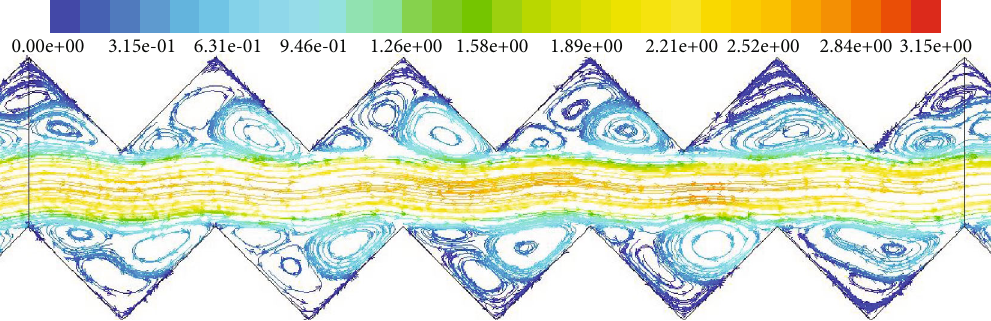
Figure 20: Flow-line